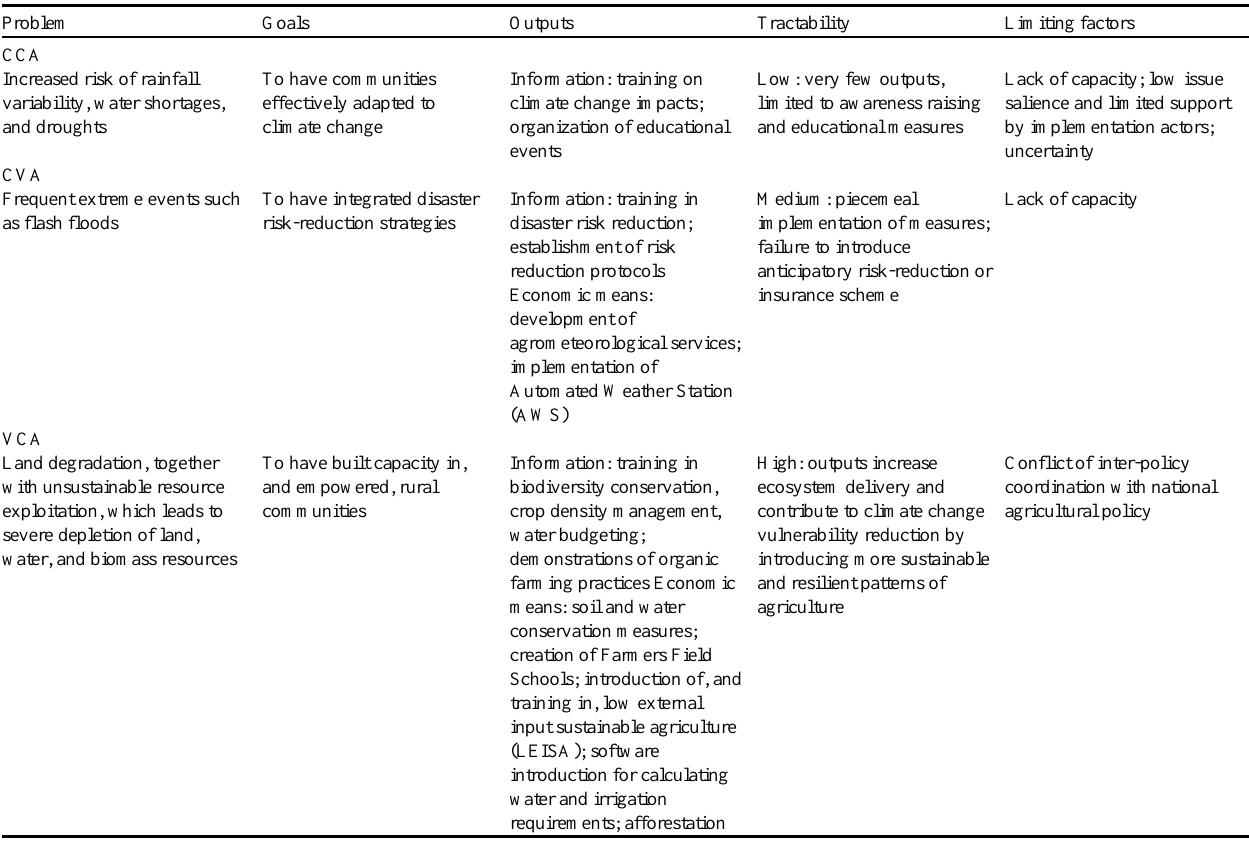
Table 4. Summary of WOTR program and analysis of